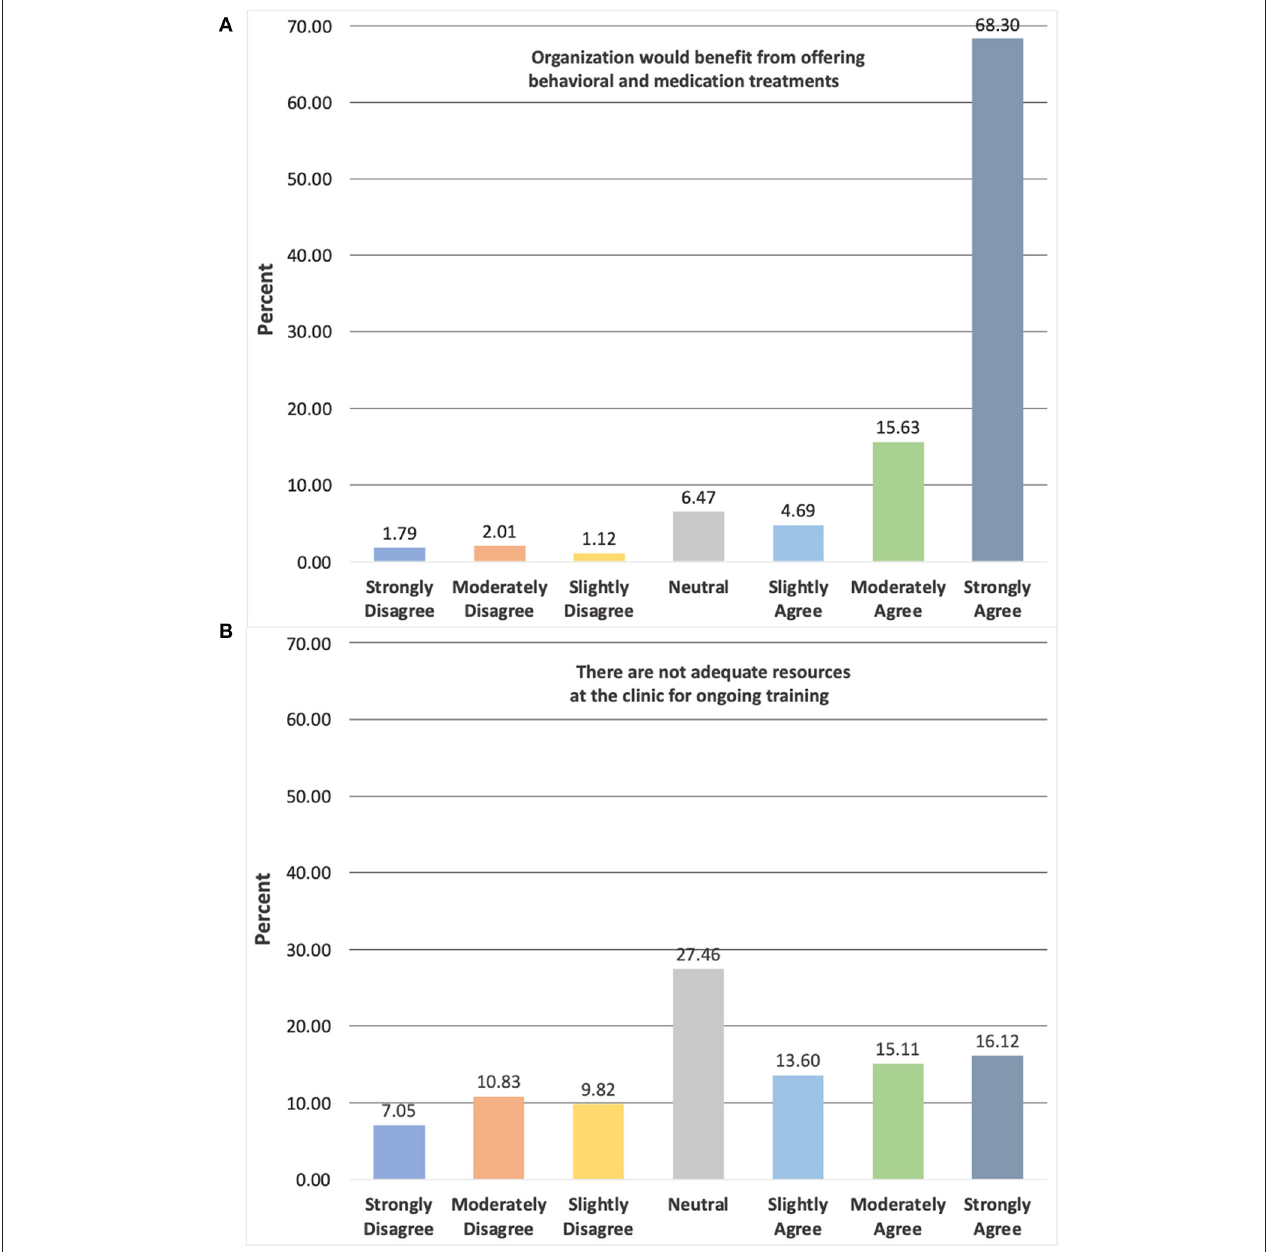
FIGURE 2 | Breakdown of provider agreement for selected clinic-level items across agencies. Items rated on 7-point Likert scale ranging from “Strongly Disagree” (1) to “Strongly Agree” (7); total number of respondents differs for each survey item depending on response rates: (A) = 448, (B) =